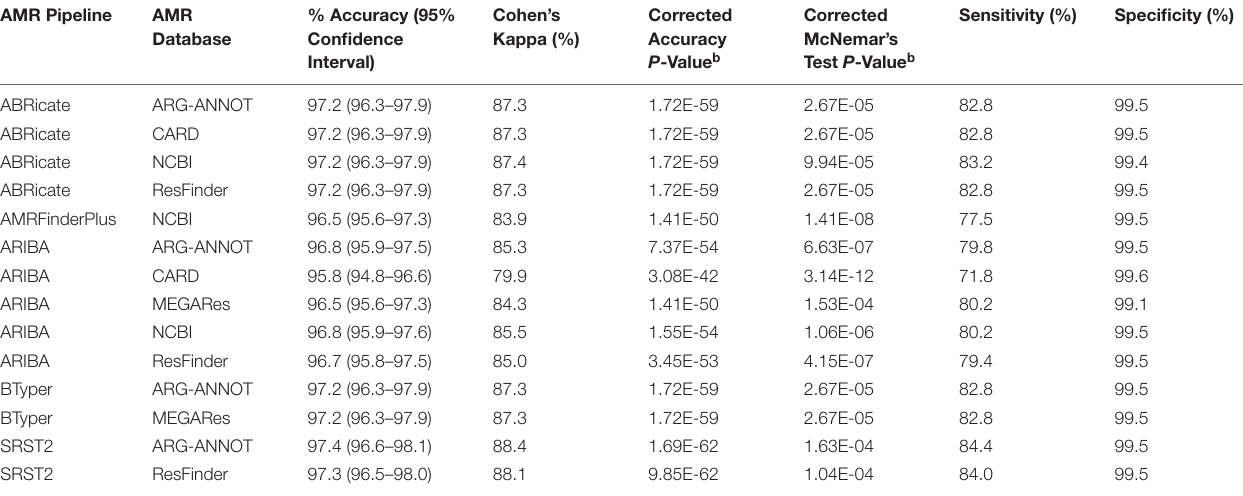
TABLE 1 | Statistics for the 15-antimicrobial phenotypic susceptibility/resistance prediction task for all antimicrobial resistance (AMR) determinant pipeline/database combinations a